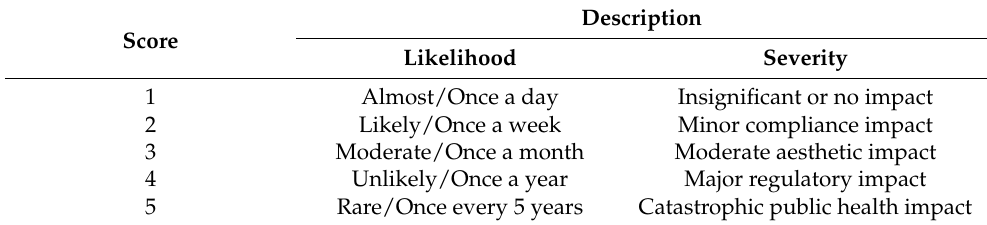
Table 3. Scoring criteria for the likelihood and severity of hazardous events